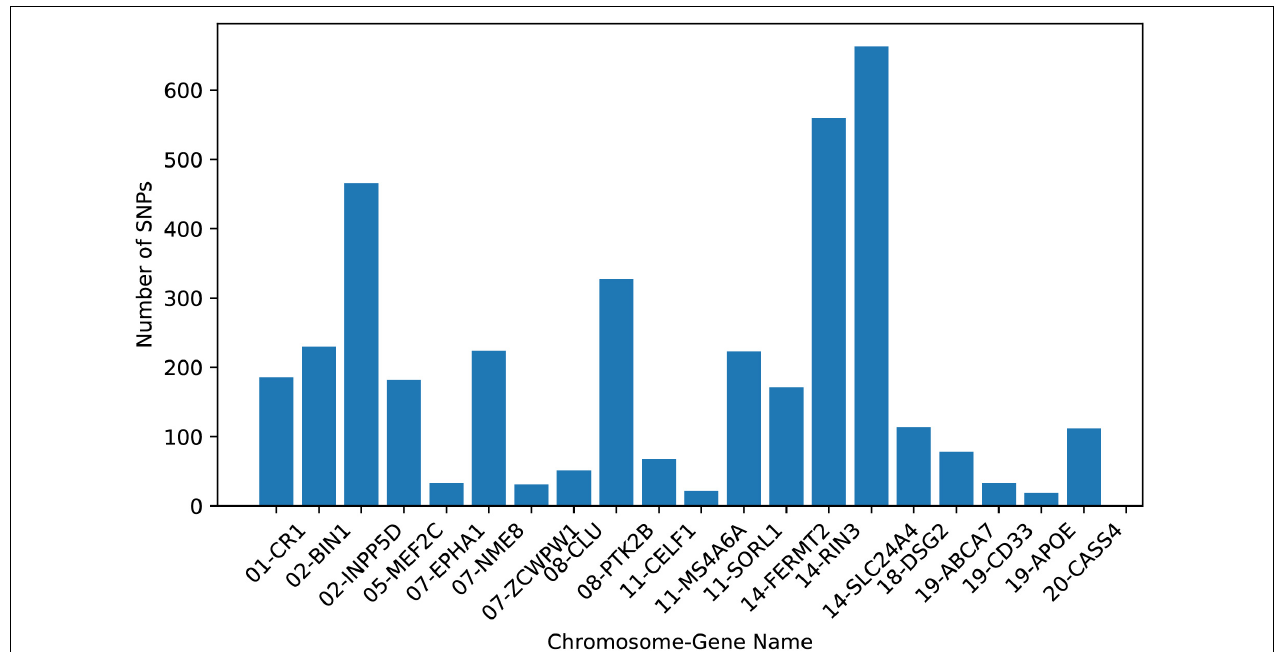
FIGURE 1 | The numbers of SNPs belonging to each AD risk gene used in this study.